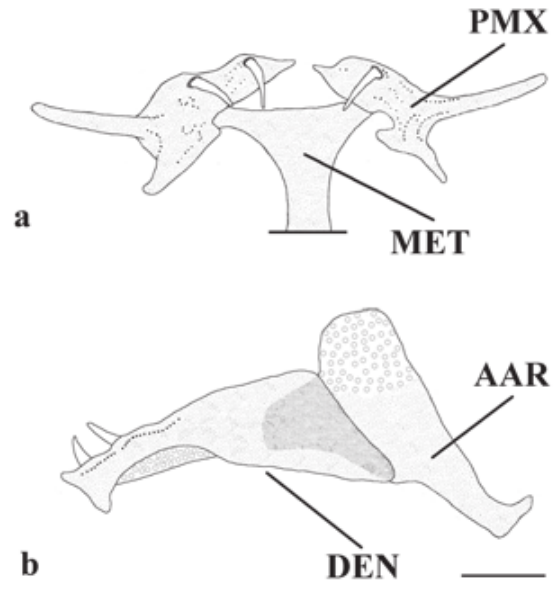
Fig. 3. Jaws of Trichomycterus anhanga , MZUSP 108822. Scale bars = 0.1 mm. a ) upper jaw in ventral view; b ) lower jaw in ventrolateral view, left side. PMX = premaxilar, MET = mesethmoid, DEN = dentary; AAR =